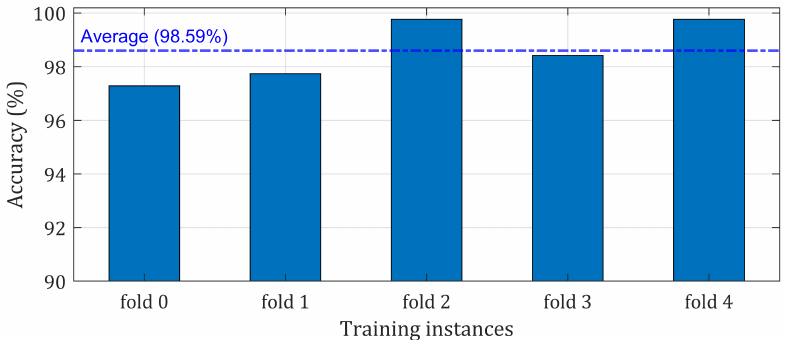
Figure 12. Cross-validation accuracy on validation folds.